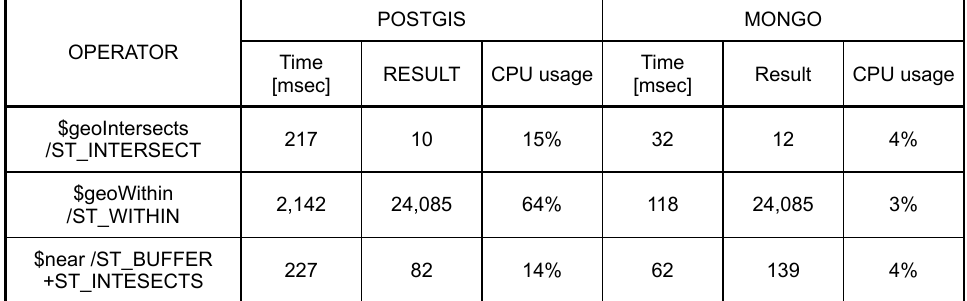
Tab. 6. Summary of CPU percentage usage and queries execution time for all